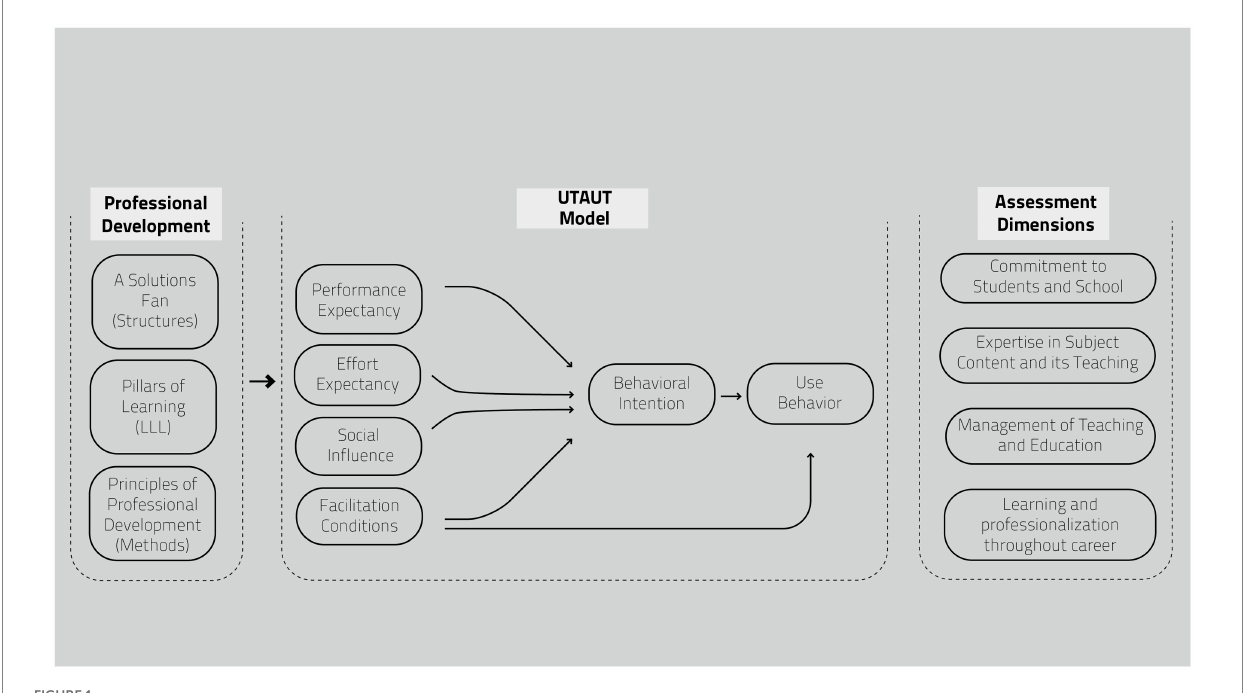
FIGURE 1 Research model.